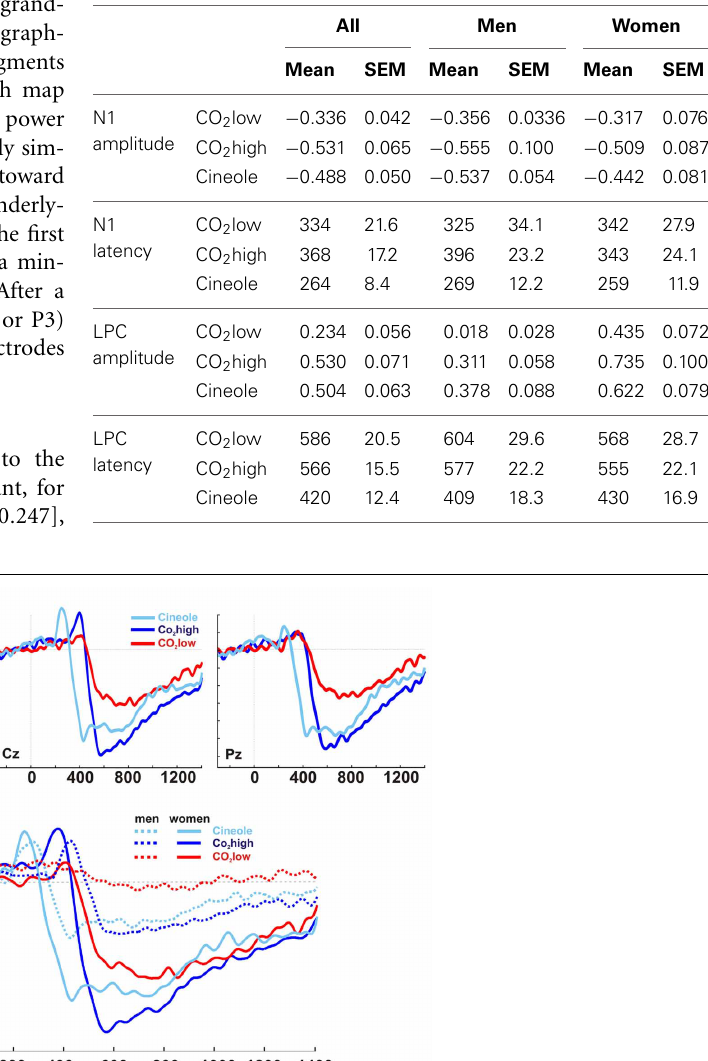
Table 1 | ERP peak latencies (in ms) and amplitudes (in µ V).